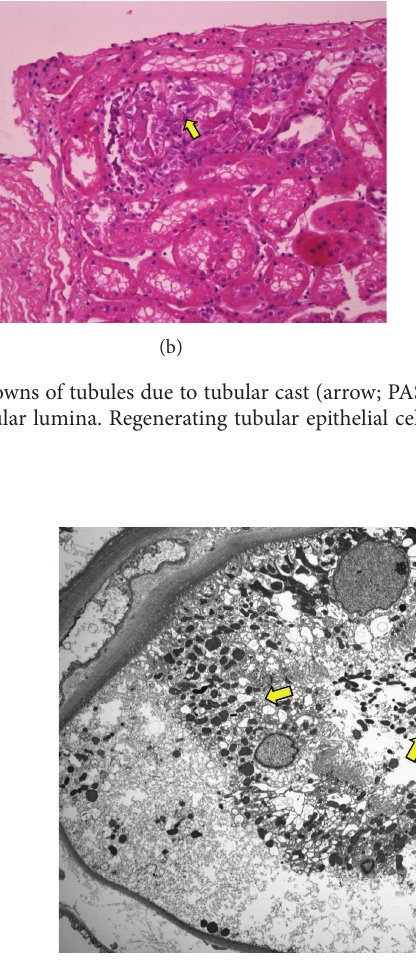
Figure 3: Ultrastructural examination of proximal tubules shows electron-dense lysosomes in both cytoplasm and tubular lumina (thick arrows) (TEM ×